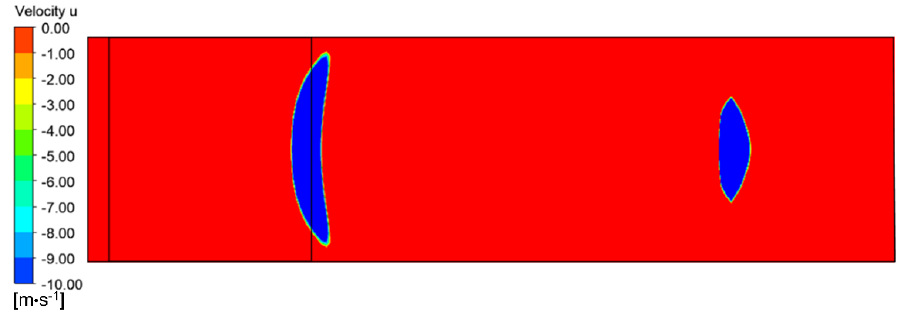
Figure 11. Velocity contour of ISWBLI at y = 0 cross section. The specific location of the separation zone could be determined based on the skin friction coefficient C f . Figure 12 represents the change curve of C f at the z = 0 cross section and, as can be seen, at the central cross section of the plate, C f had a negative value from x = 0.126 m to x = 0.146 m in the flow direction. This indicates that the length of the sepa- ration zone at the central cross section of the plate was 20 mm. Figure 13a,b shows the skin friction coefficient curves at the z = 0.025 m cross section and z = 0.054 m cross section, respectively. It can be interpreted from the figure that, at z = 0.025 m, the separation zone was about 16 mm in length from x = 0.0136 m to x = 0.0152 m. At z = 0.054 m cross section, the separation zone was located at x = 0.146 m~x = 0.153 m with a length of 7 mm. The separation moved backward with a smaller size. This result